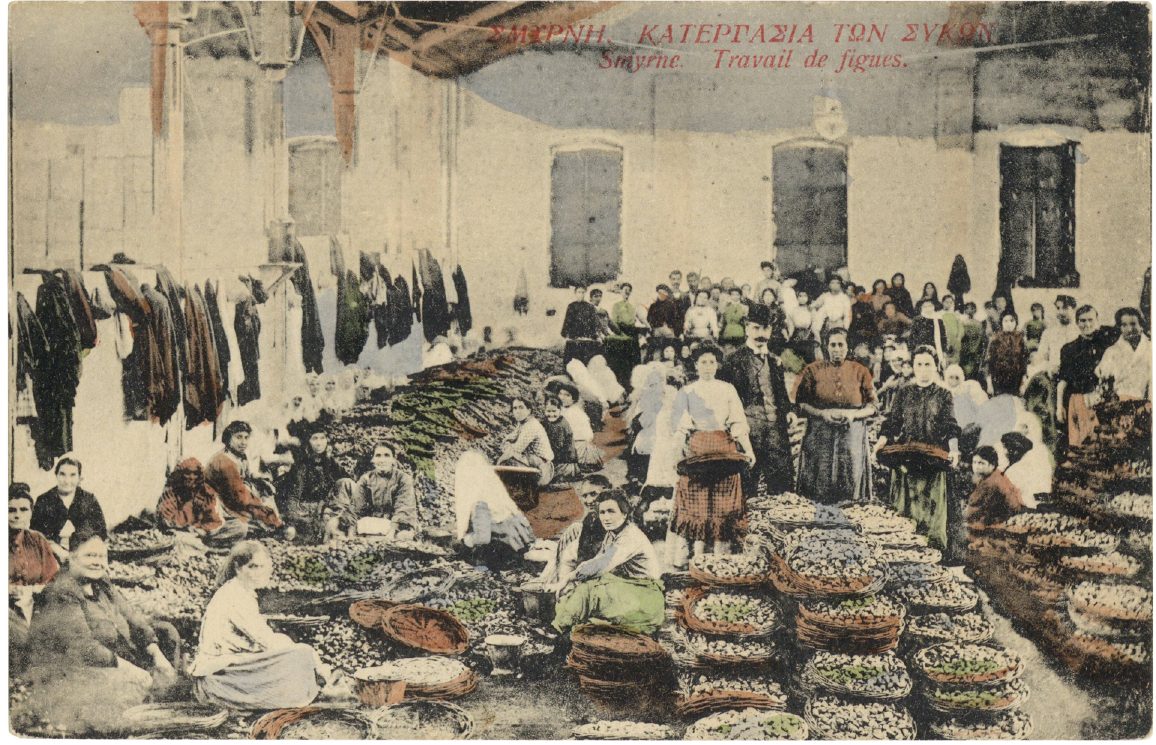
FIG. 7 Female fig sorters in Smyrna market, ©SALT Research.